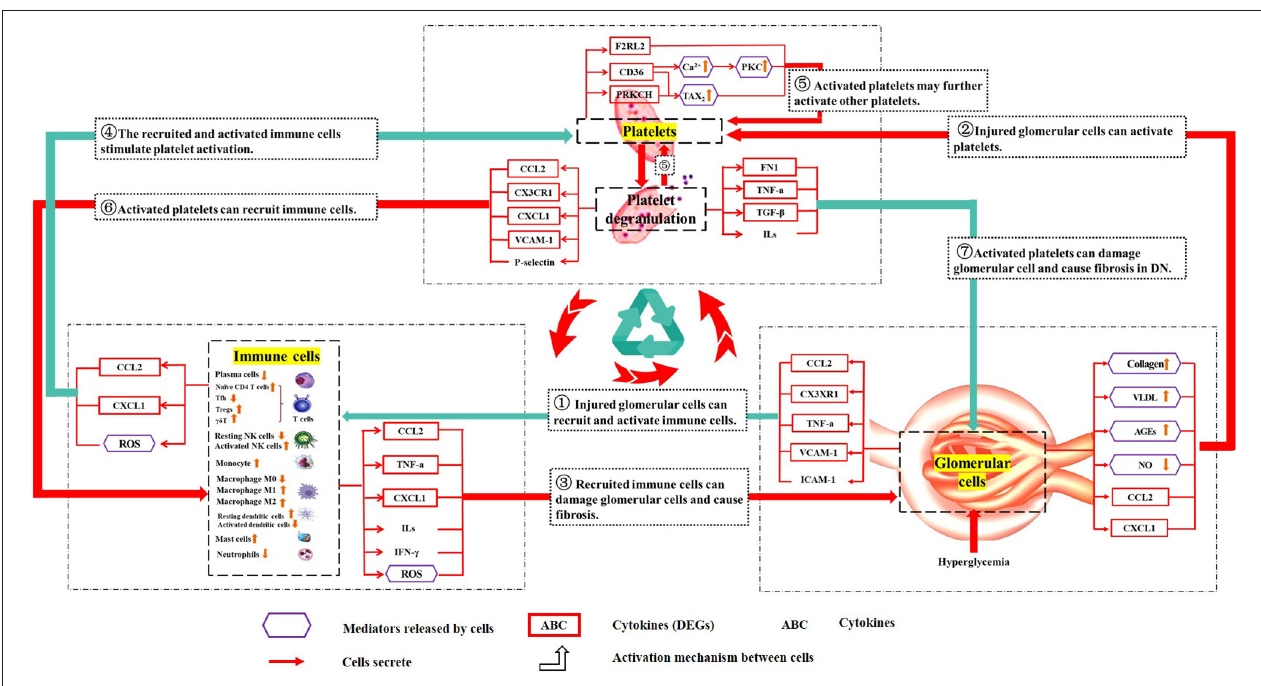
FIGURE 7 | Schematic diagram describing the crosstalk among platelets, immune cells, and the glomerulus. The purple hexagonal box lines represent cellular mediators. The red box indicates the protein expressed by DEGs. The frameless protein was not expressed by DEGs. “ mechanism between cells (the red line is glomerular cells-immune cells-platelets, and the blue line is glomerular cells-platelets-immune cells). ‹ Injured glomerular cells can recruit and activate immune cells. › Injured glomerular cells can activate platelets. fi Recruited immune cells can damage glomerular cells and cause fibrosis. fl The recruited and activated immune cells stimulate platelet activation. (cid:176) Activated platelets may further activate other platelets. – Activated platelets can recruit immune cells. † Activated platelets can damage glomerular cells and cause fibrosis in DN. The above is the hypothetical crosstalk among the glomerulus, immune cells, and